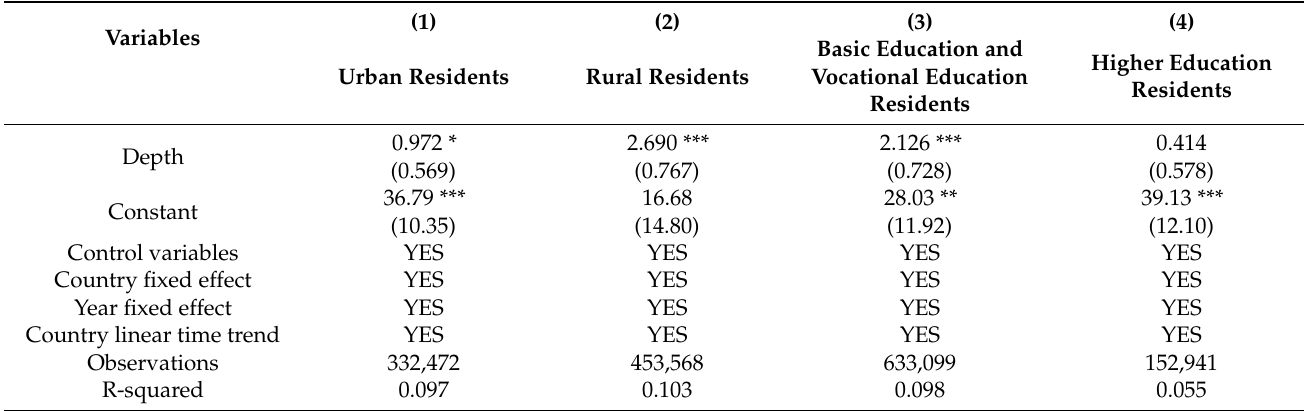
Table 9. Results based on different types of